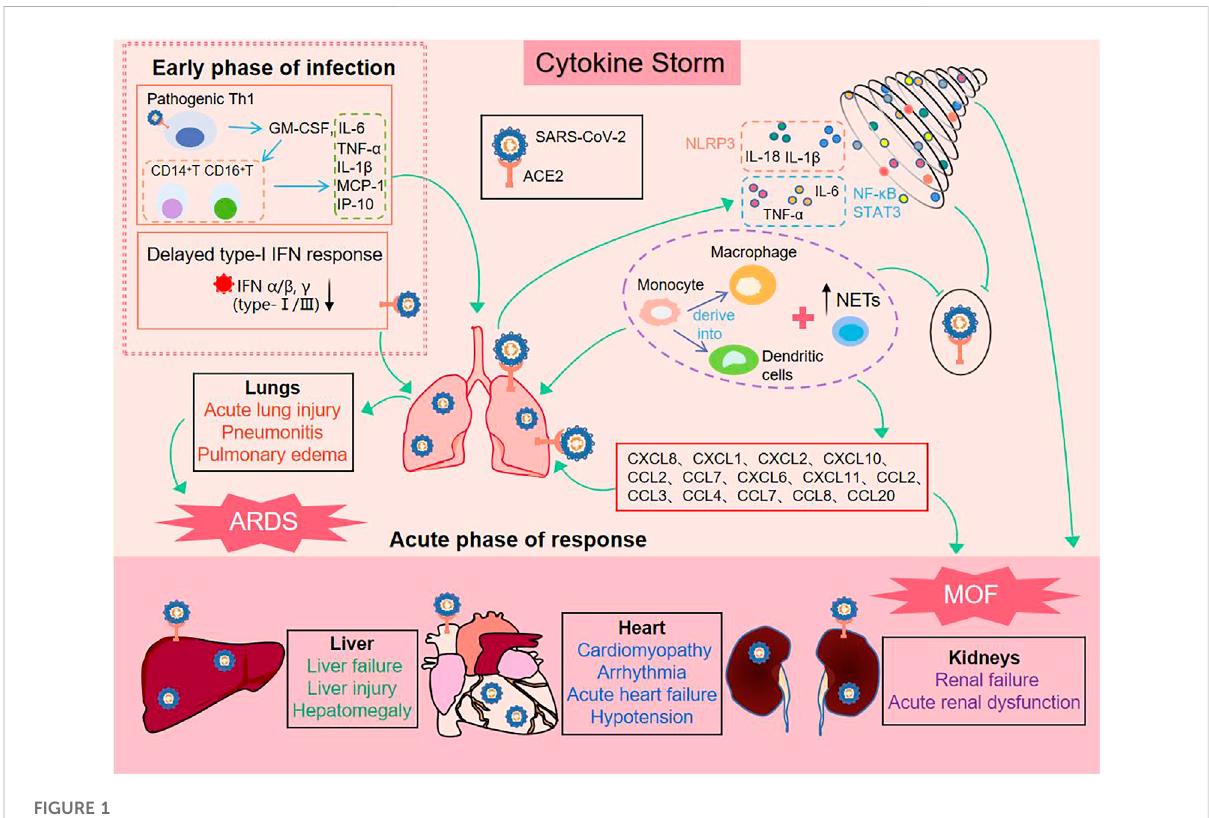
FIGURE 1 Process of cytokine storm production induced by